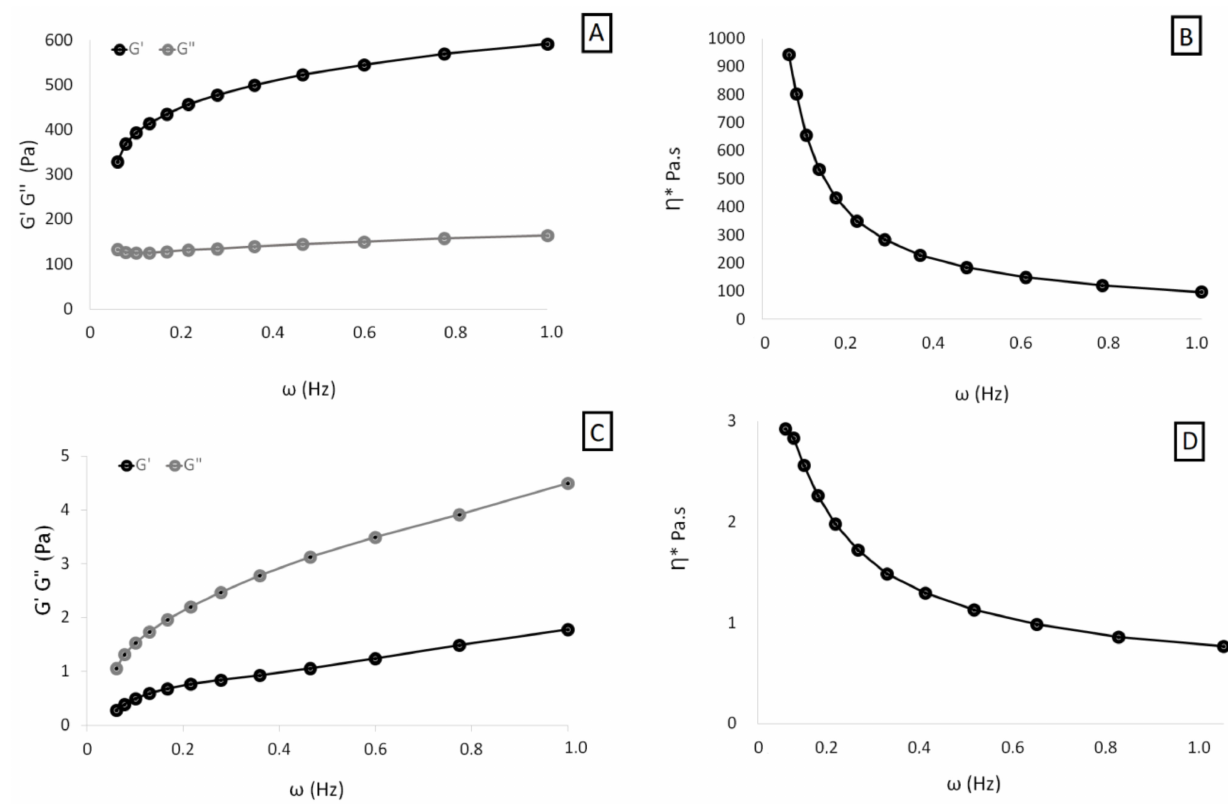
Figure 2. Elastic (G (cid:48) ) and viscous (G (cid:48)(cid:48) ) moduli and complex viscosity of ewe’s ( A , B ) and goat’s ( C , D ) yoghurts produced with UF concentrated cheese